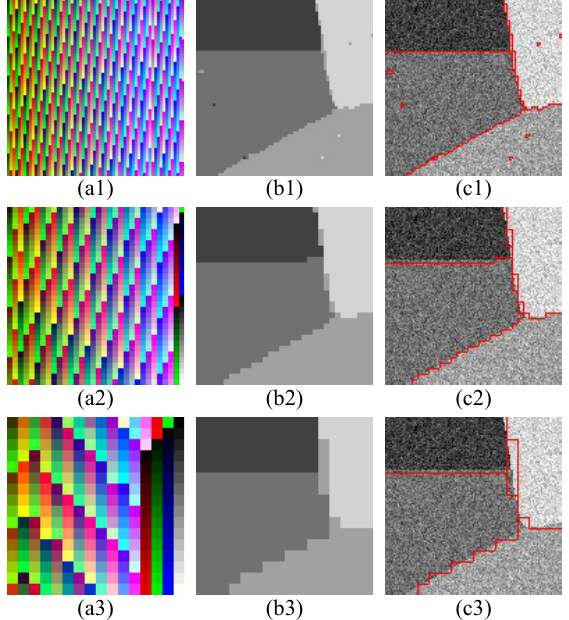
Figure 2. Segmentation result of the simulated image with the proposed